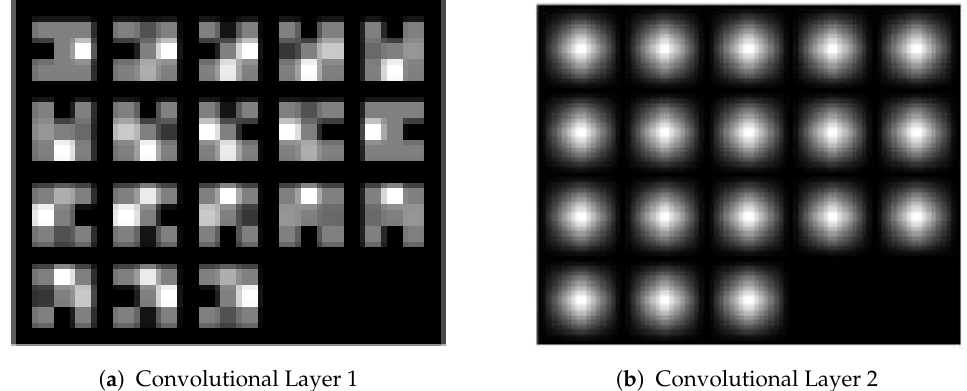
Figure 4. Visualization of the initial parameters of the convolutional layers.